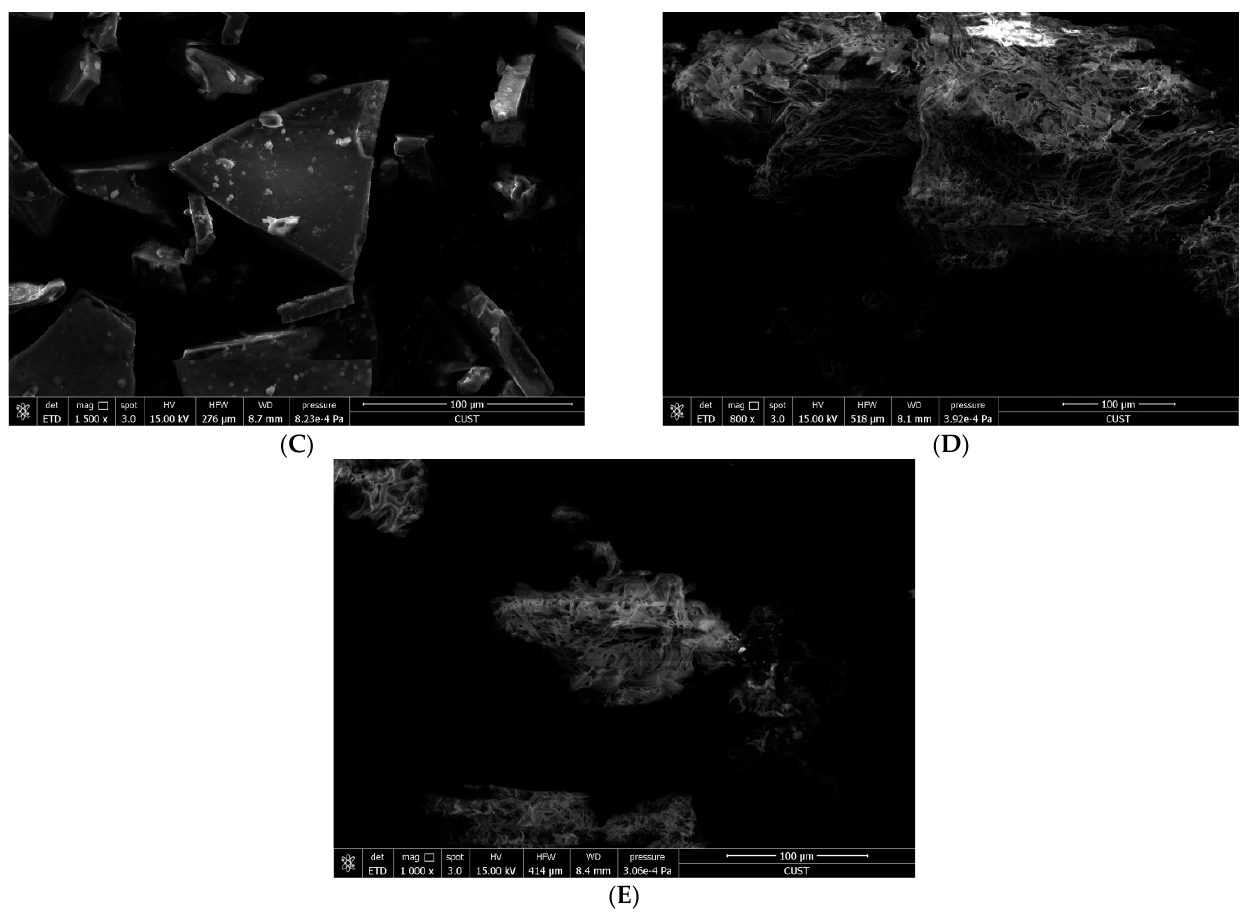
Figure 1. SEM images for AC-SDF ( A ), AL-SDF ( B ), EN-SDF ( C ), H-SDF ( D ) and U-SDF ( E ). A, Acid; Al, Alkali; En, Enzyme; H, Homogenization; U,